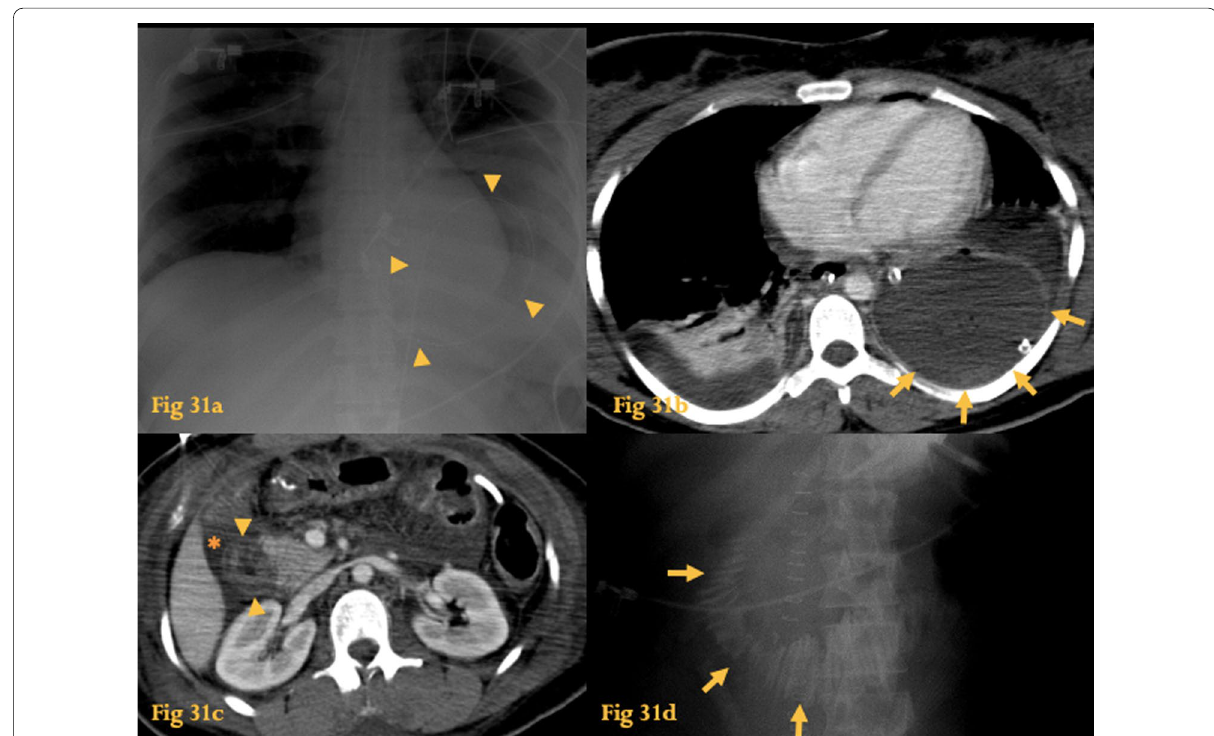
Fig. 31 Trauma. Chest radiograph ( a ) of a car accident victim shows a gastric tube with a thoracic loop (arrowheads). Contrast‑enhanced CT of the same patient ( b ) confirms traumatic diaphragmatic hernia; note the absence of interposition of lungs between the stomach and the chest wall— the so‑called “dependent viscera sign” (arrows). Abdominal CT ( c ) shows that D2 is surrounded by fluid (asterisk) and its wall presents the target sign (arrowheads). The upper GI study ( d ) of the same patient revealed uniform, regular, fold thickening at D2 and D3, similar to a stack of coins (arrows), representing intramural edema/hematoma